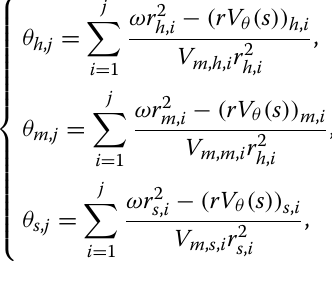
mixed-flow pump, which is shown in Figure 3(a). The results indicate that each cross section is controlled by ten wrap angles. According to Eq. (2), the wrap angle of the j th point for these cross sections can be calculated as: